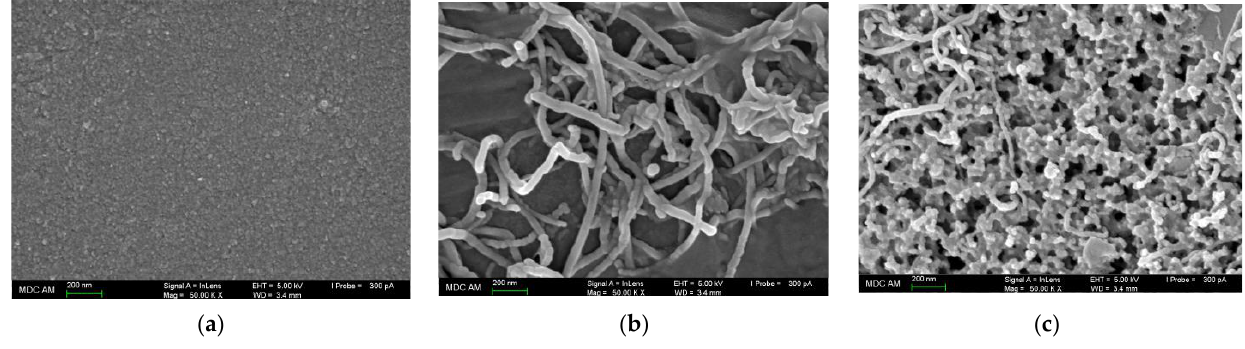
Figure 4. SEM images of: ( a ) bare GCE; ( b ) MWCNTs/GCE; ( c ) Poly( p -ABA)/MWCNTs/GCE.